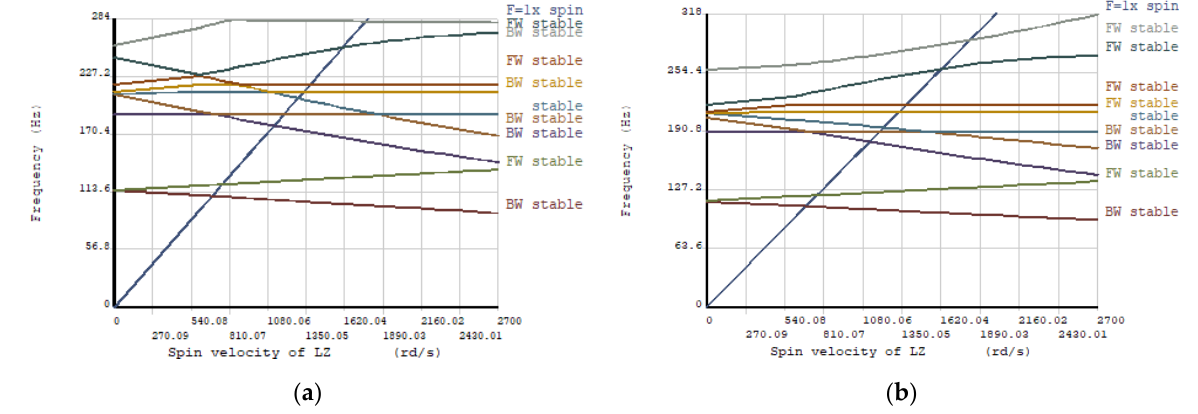
Figure 21. Campbell diagram of parallel non-concentricity: ( a ) δ = 1 mm; ( b ) δ = 2 mm.